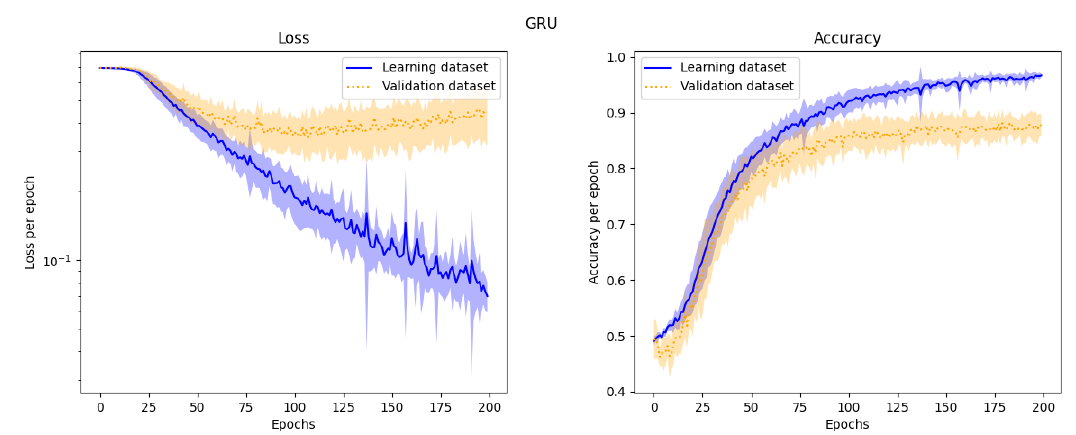
Figure 4. Average loss and accuracy of the models with GRU over learning epochs.